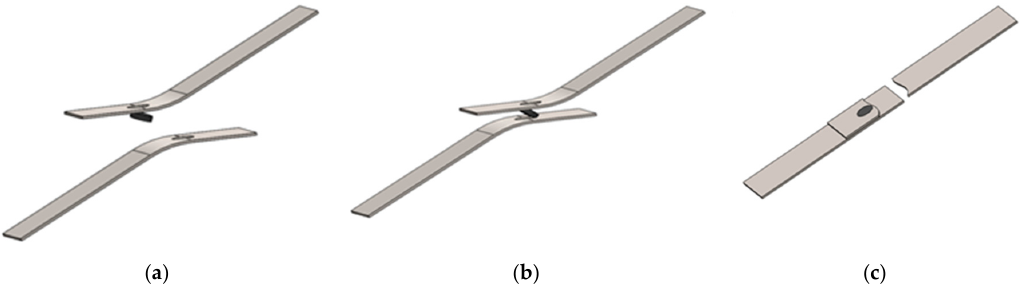
Figure 7. Failure modes after fatigue test: ( a ) pull-out failure, ( b ) plug failure, and ( c ) HAZ failure. Table 5. Fatigue failure modes of welds with electrode face diameters of 8 mm and 10 mm according to the fatigue load.